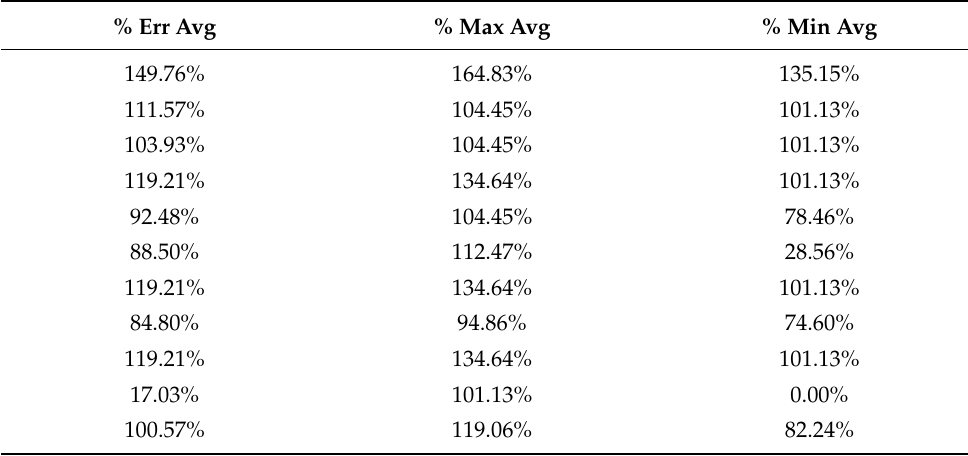
Table A211. Set 3, trials 31–40 data (all 0.5 PR values).